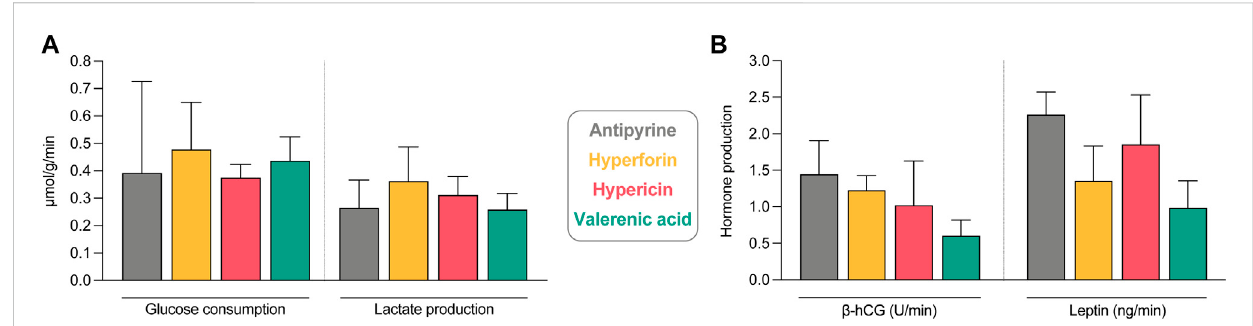
FIGURE 7 Assessmentoftissueviabilityandfunctionalityduringthe exvivo humanplacentalperfusion. (A) Glucoseconsumptionandlactateproductionunder exposure to study compounds and antipyrine (from control perfusions). Displayed are the changes between beginning and end of the perfusion in fetal and maternal circuits. Data are normalized by the total perfusion time (min) and perfused cotyledon weight (g). All data are represented as mean ± SD of three to four independent experiments. (B) Beta-human choriogonadotropin ( β -hCG) and leptin tissue production of perfusions with study compounds and antipyrine (from control perfusions). Displayed is the net release rate of placental hormones during the placental perfusion, normalized bythetotalperfusiontime(min).Alldataarerepresentedasmean±SDofthreetofourindependentexperiments(exceptfortheleptinvalueofantipyrine, where only two values are included). No statistically signi fi cant differences were found between the groups ( p > 0.05 in all